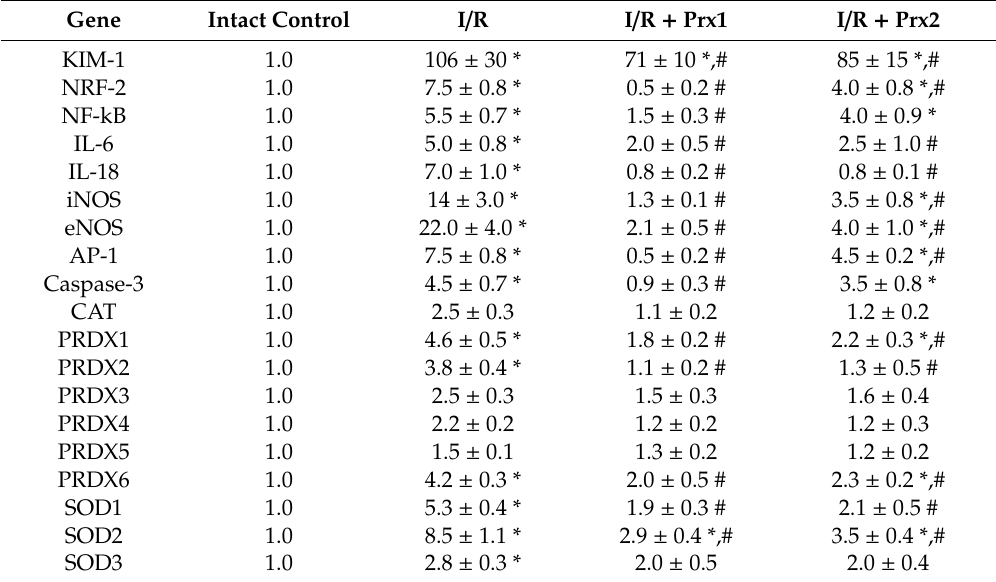
Table 6. Changes in the expression level of genes 24 h after I / R injury relative to the intact animals. Gene Intact Control I / R I / R + Prx1 I / R + Prx2